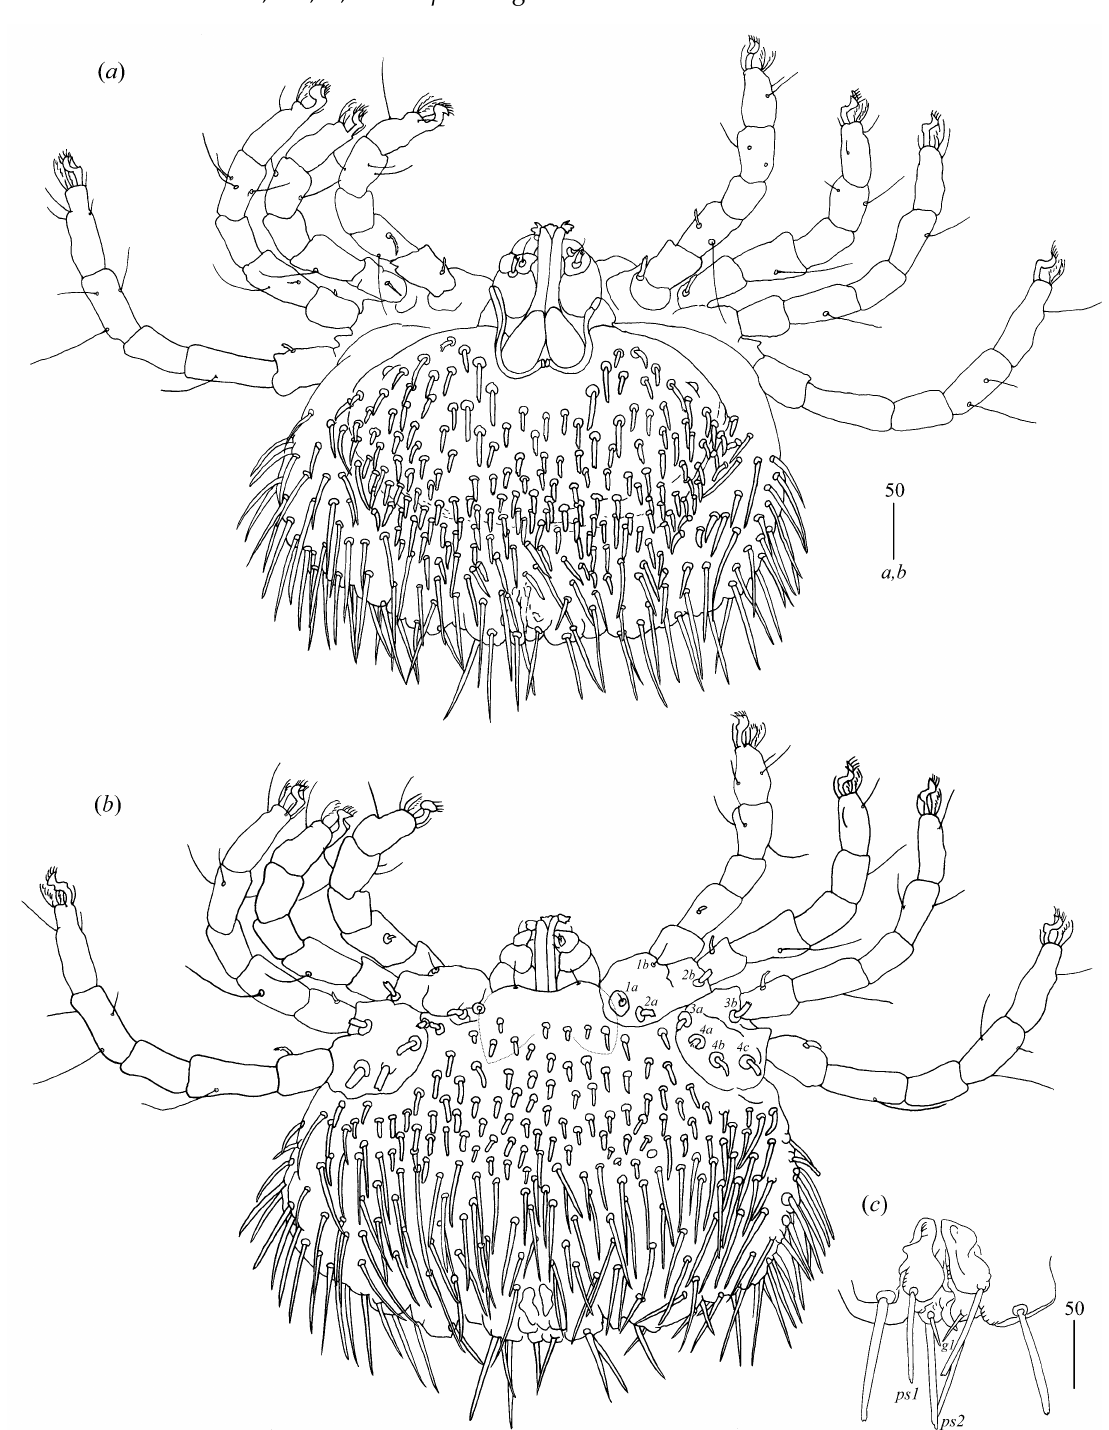
Figure 1. Geckobia gigantea sp. n. female: ( a ) in dorsal view; ( b ) in ventral view; ( c ) genital region, enlarged.